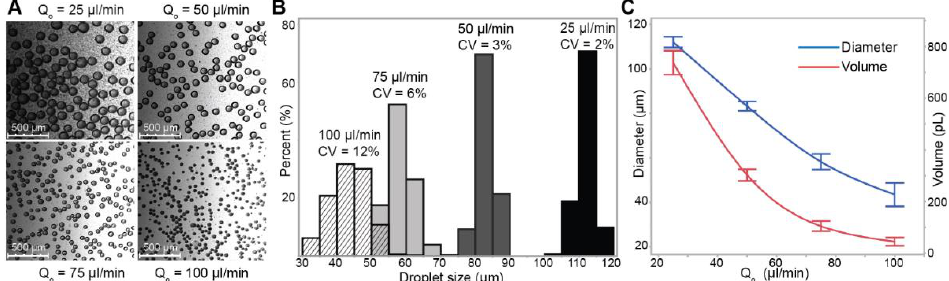
Figure 2. Picoliter-scale droplet generation. ( A ) Micrograph of the droplets retrieved from microflu- idic cartridge outlet. ( B ) Droplet diameter distribution and CV at each flow condition. ( C ) The droplet diameter changes with volumetric flow rate of the oil phase. The volumetric flow rate of the aqueous phase was kept constant at 1 µ